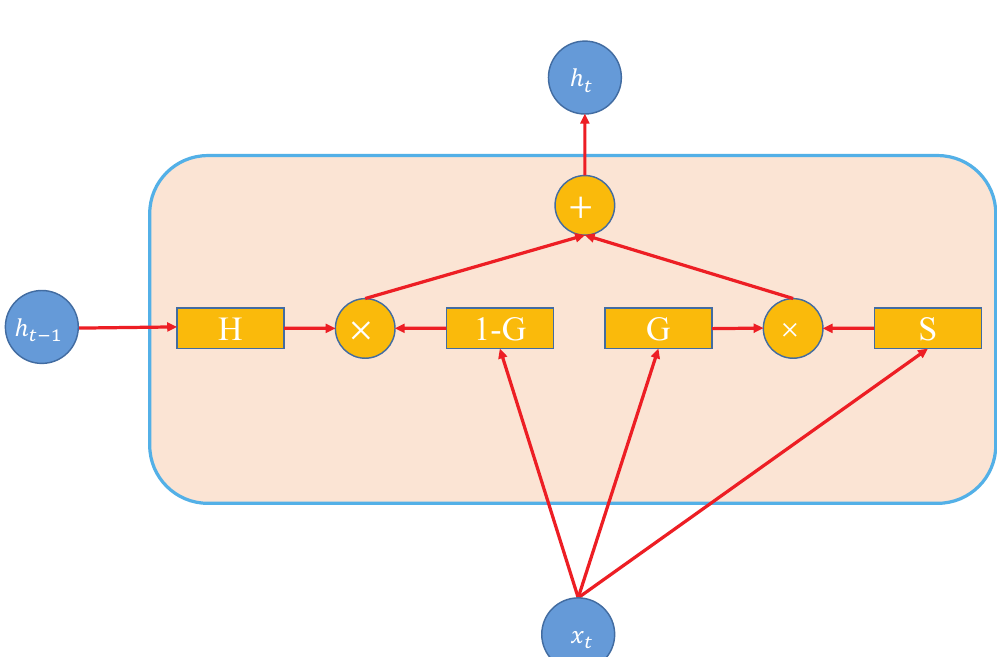
Figure 5. The cell of gate-RNN. It contains two gates to control the input information and history information. It uses G to control input information and 1 − G to control history